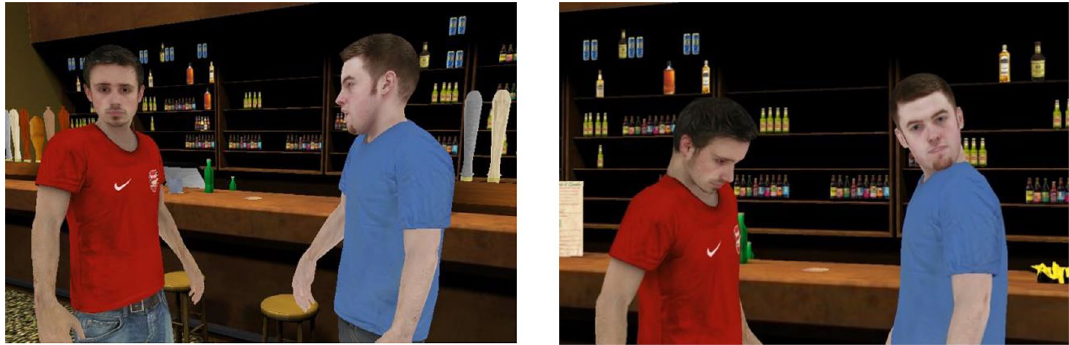
Figure 1. The character wearing the blue shirt verbally attacks the other one. Left—The victim (V) looks at the participant; Right—the perpetrator (P) looks at the